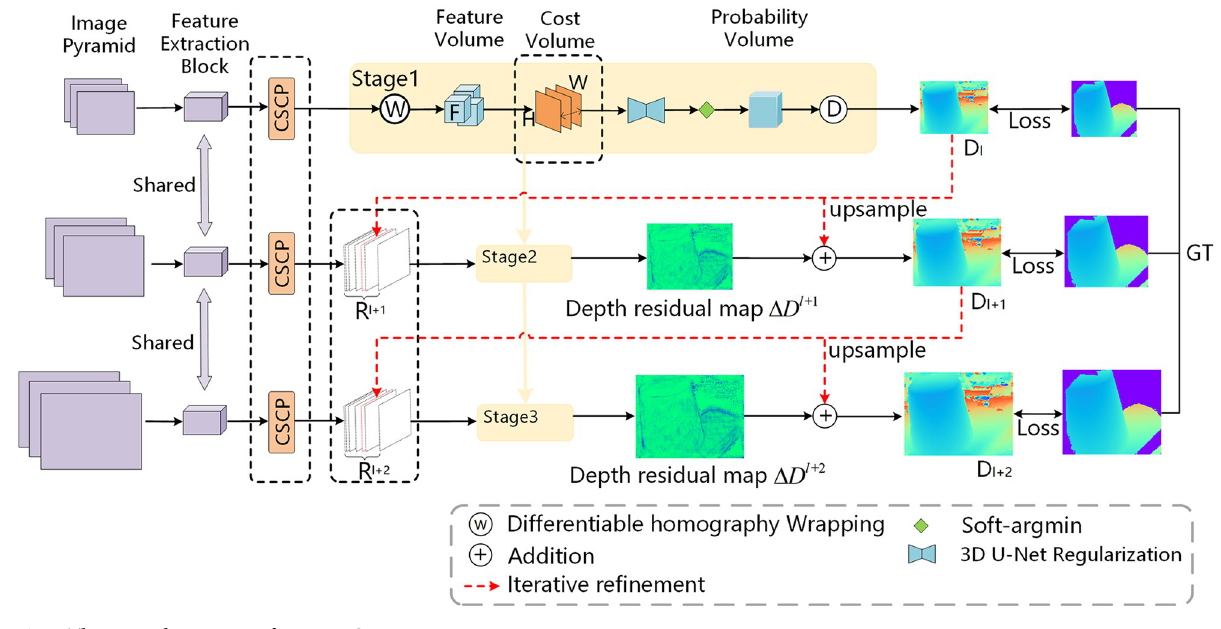
Fig 1. The network structure of